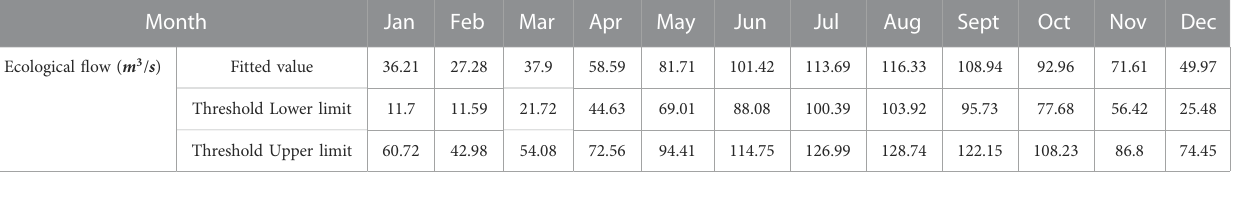
TABLE 8 Evaluation of fi tted monthly ecological fl